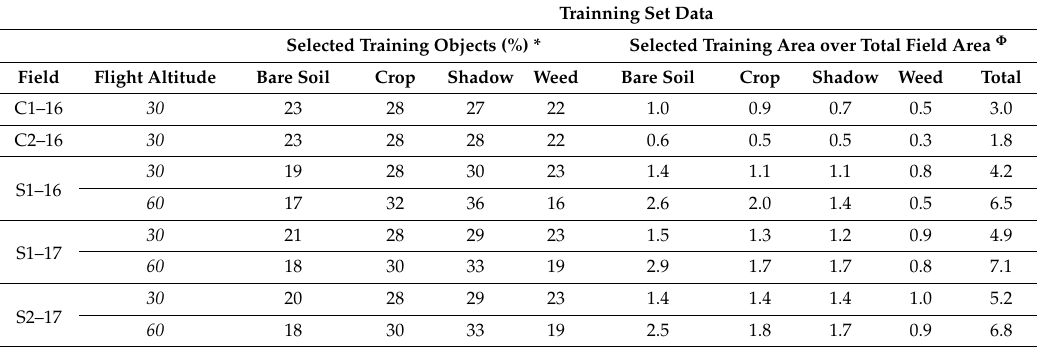
Table 2. Description of the training set automatically selected by the RF classifier implemented in the OBIA algorithm.